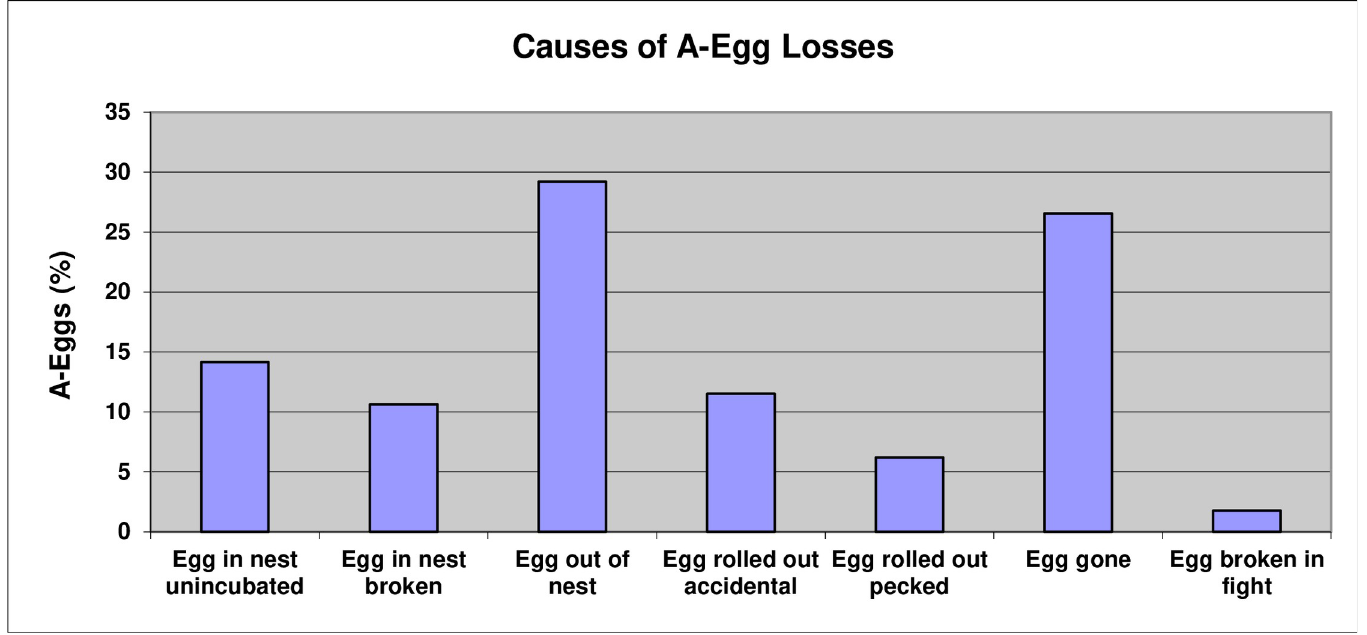
Fig 4. Causes of losses of A-eggs laid in the Study Colony (n =